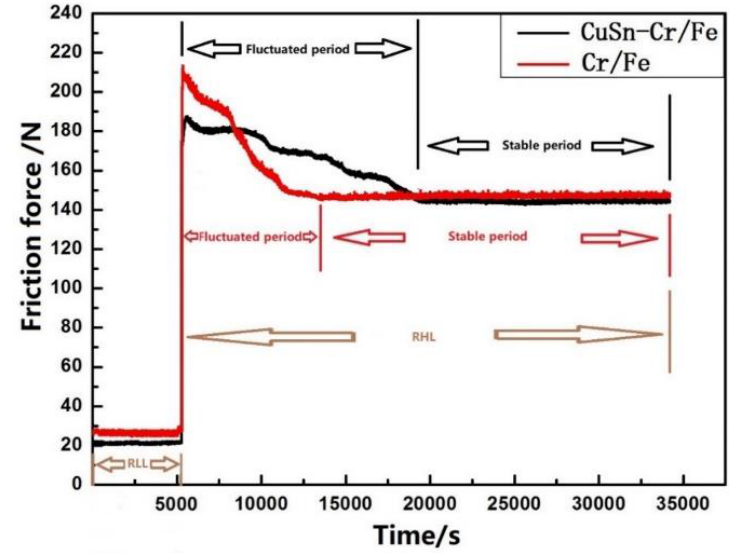
Figure 6. Friction force variation of the CuSn-Cr/Fe and Cr/Fe pairs at the dead center.